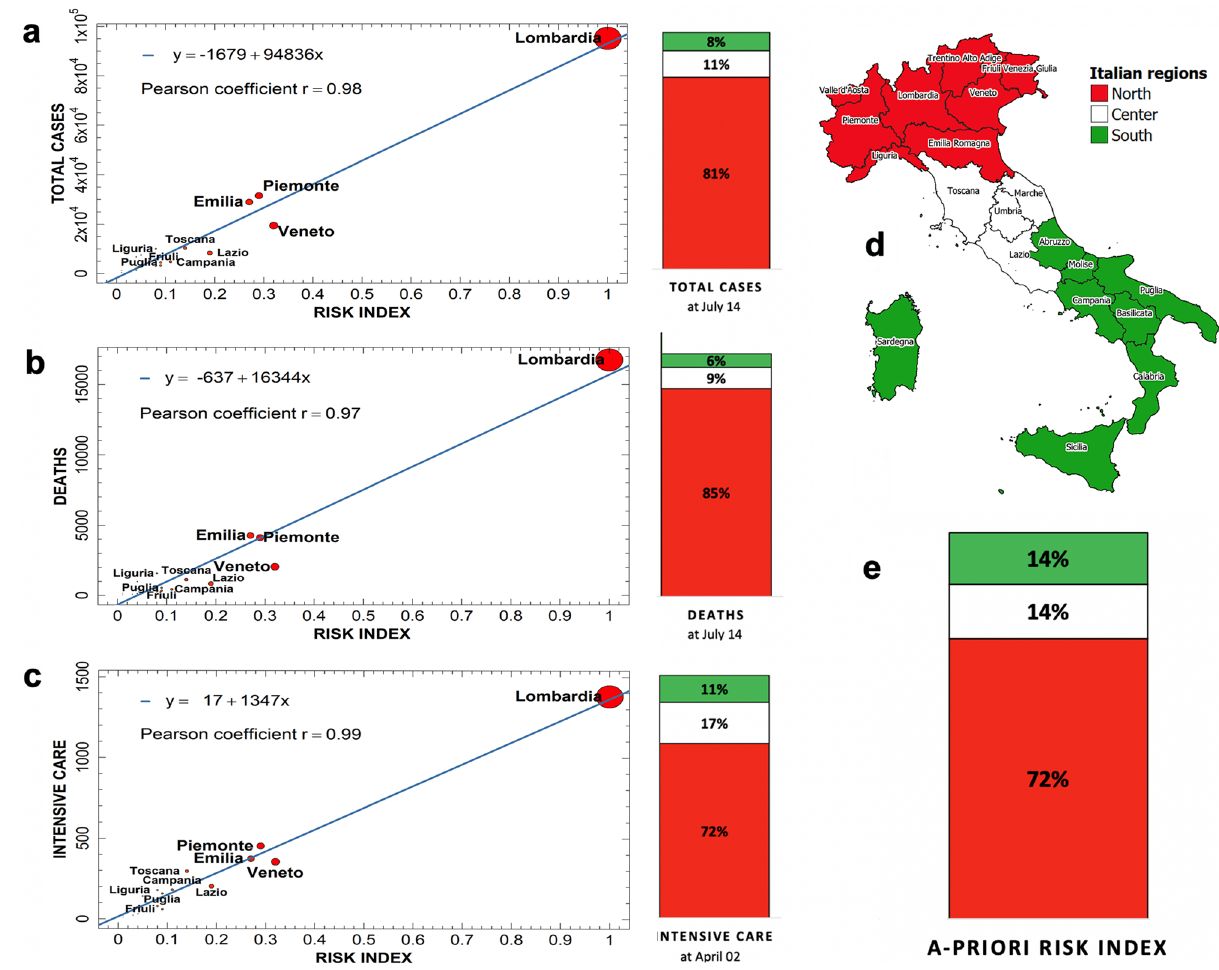
Figure 4. The three main impact indicators for COVID-19—the total number of cases ( a ) and the total number of deaths ( b ) cumulated up to July 14, 2020 4 , and the intensive care occupancy (c) at April 2, 2020 4 —are reported as function of the a-priori risk index for all the Italian regions. The size of the points is proportional to the risk index score. A linear regression has been performed for each plot. The Pearson correlation coefficients are very good, always greater or equal than 0.97. The corresponding percentages of damages, aggregated for the three Italian macro-regions (North, Center and South ( d )) are also reported to the right and can be compared with the percentages of cumulated a-priori risk ( e ). It is clear that our a-priori risk index is able to explain the anomalous damage discrepancies between these different parts of Italy. Maps were realized with QGIS 3.10 (https:// qgis. org/ en/